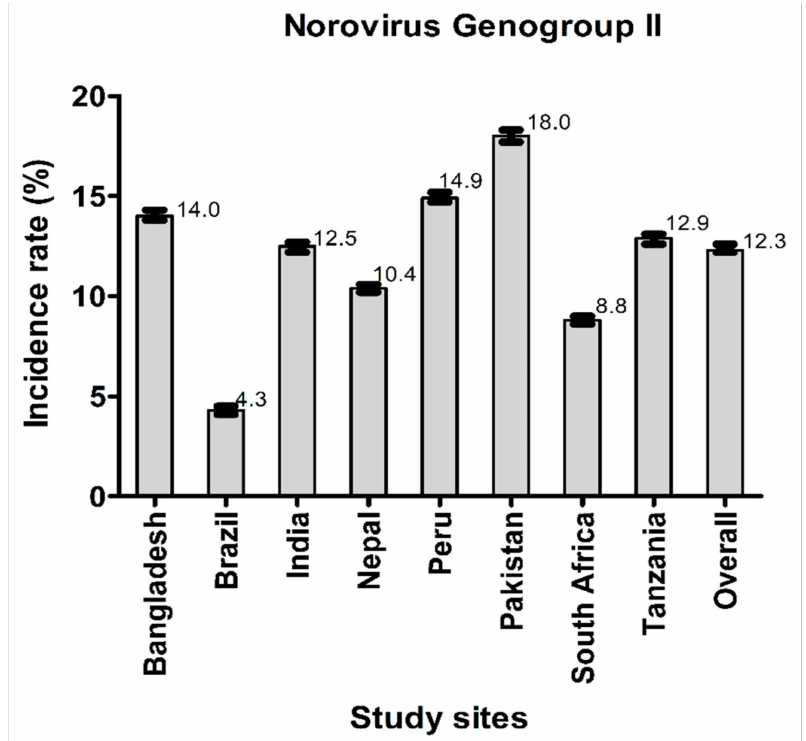
Figure 3. Incidence rates of norovirus GII infections among the participants across all the study sites among all the study participants across all the study